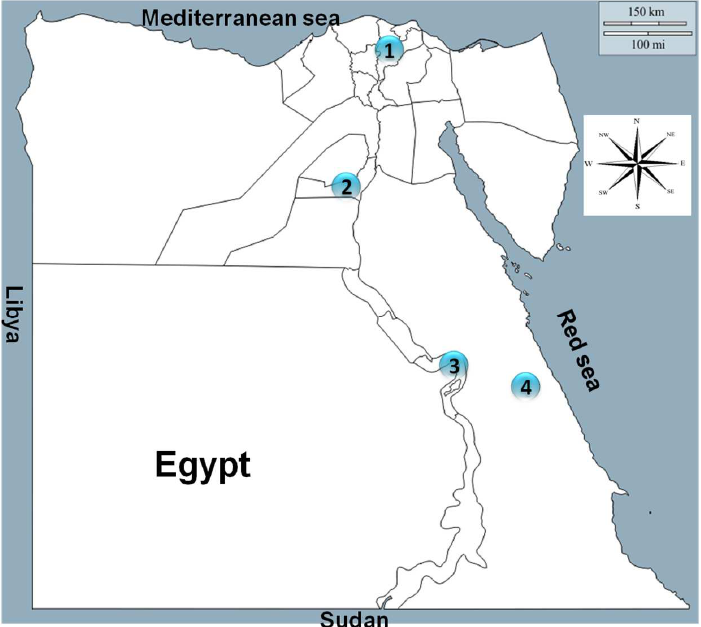
Figure 1. Geographic locations of the tested regions: 1—Dakahlia governorate (northern Egypt); 2—Beni Suef governorate (middle Egypt); 3—Qena governorate (southern Egypt); Red Sea governorate (eastern Egypt).